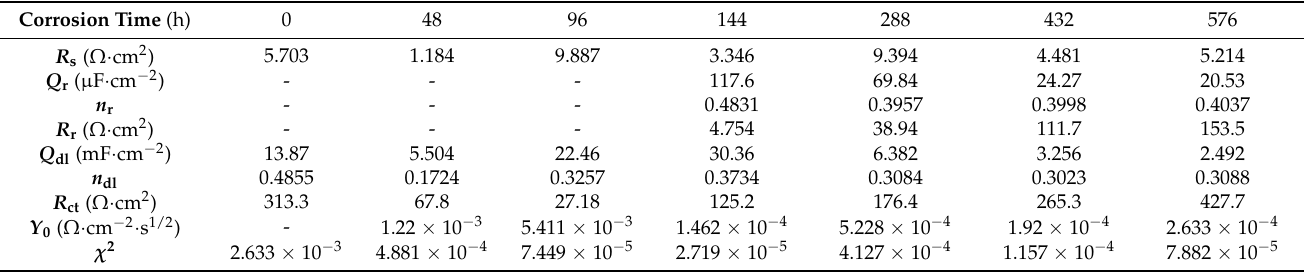
Table 5. Fitted EIS parameters for the specimens after different corrosion periods.